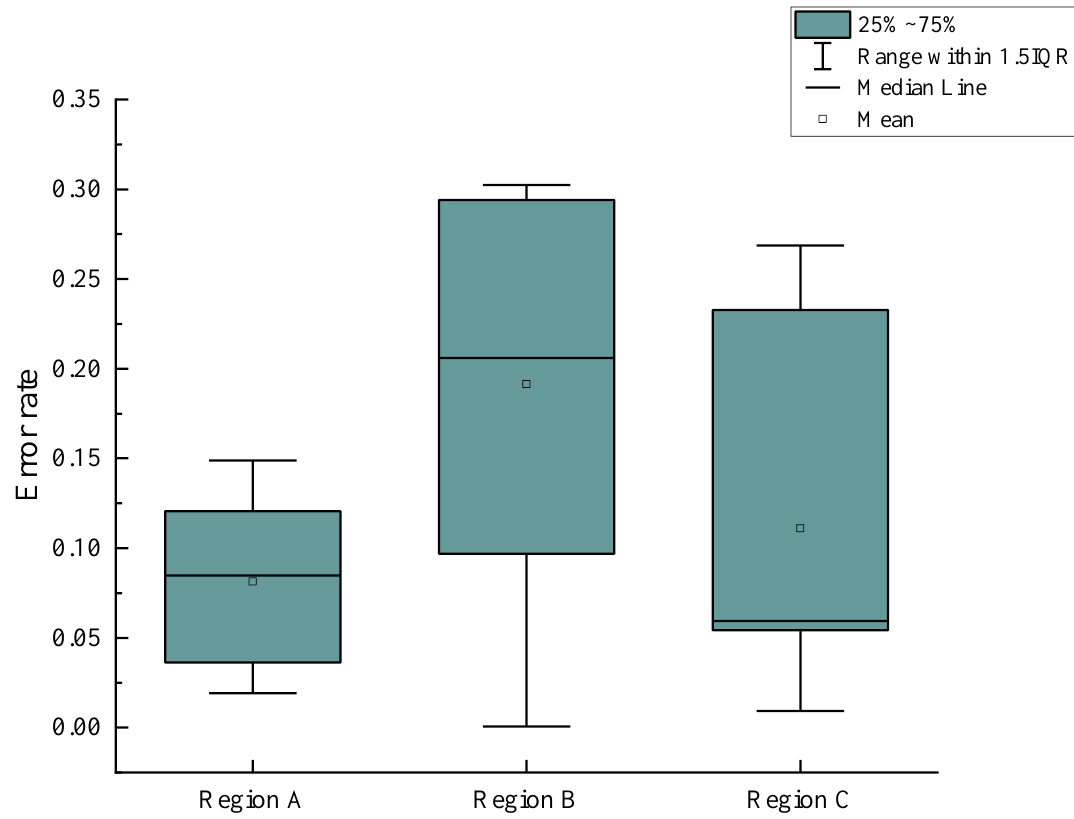
Figure 8. Schematic diagram of defect location. ( A,B,C represent different areas of the apple. ( a ) is a diagram of the top view of the apple and ( b ) is a diagram of the front view of the apple).